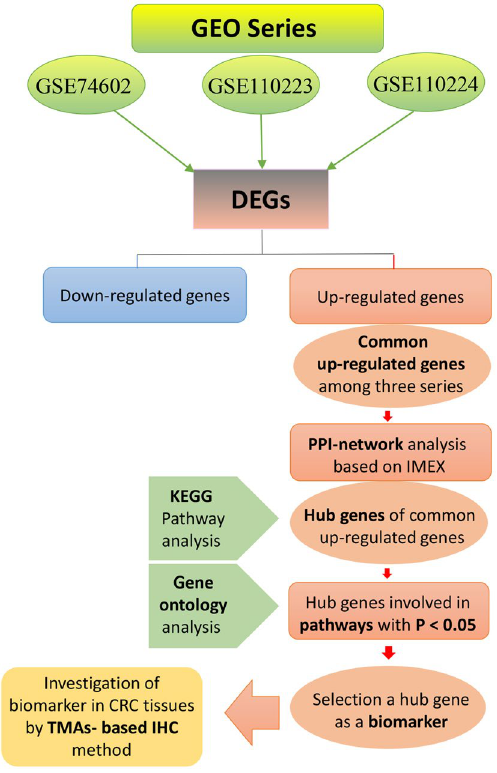
Figure 1. The workflow of the present study. This flowchart is a schematic overview of the bioinformatics analysis for selection of biomarker to investigate in CRC samples using the tissue microarrays-based immunohistochemistry (TMAs-based